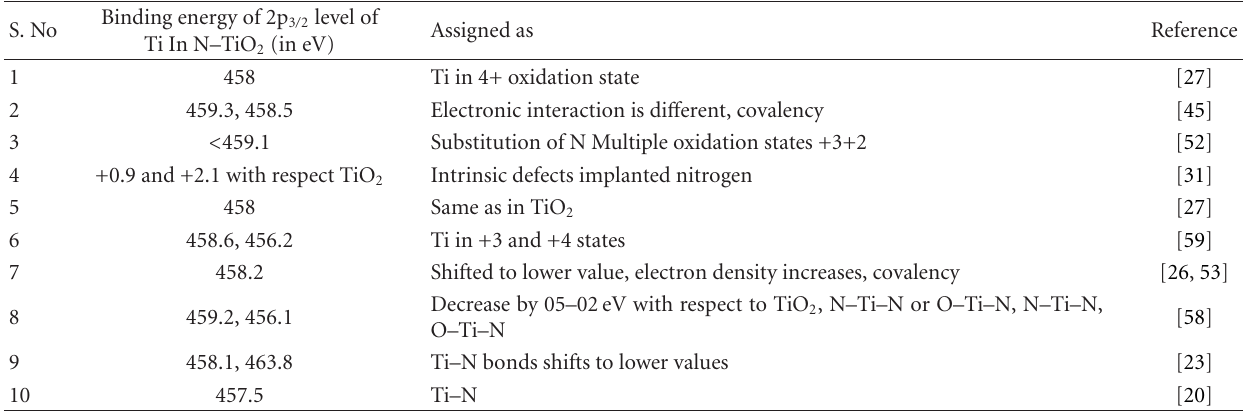
Table 2: 2p 3 / 2 binding energy values for Ti in N-substituted TiO 2